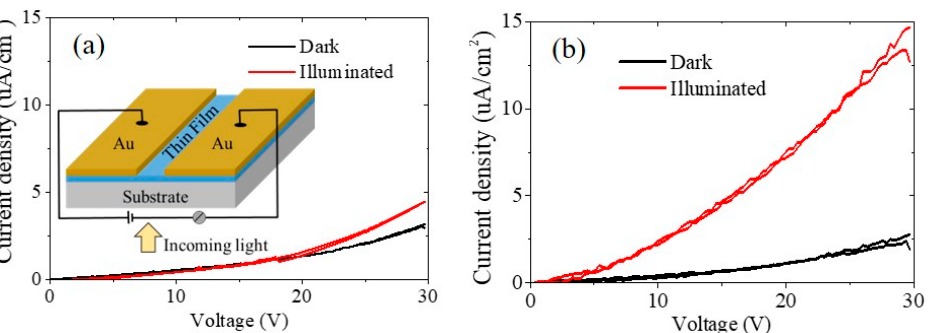
Figure 4. Current density–voltage (J-V) curves in the dark (black-colored) and under simulated solar illumination (red-colored) of zinc dross-originated ZnO nanoparticle film ( a ) without and ( b ) with dye adsorption. The inset in ( a ) is the schematic illustration of parallel metal-semiconductor-metal configuration.